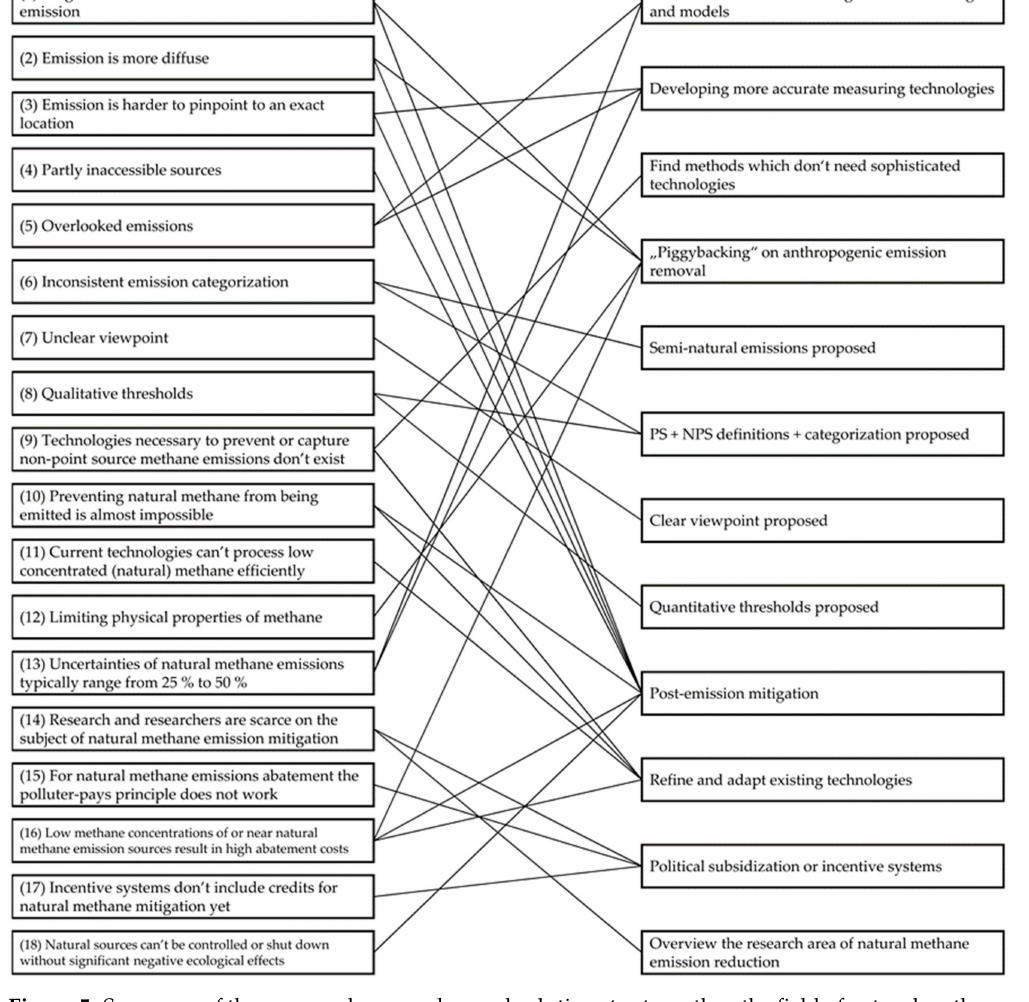
Figure 5. Summary of the proposed approaches and solutions to strengthen the field of natural methane emission mitigation. PS, point sources; NPS, non-point